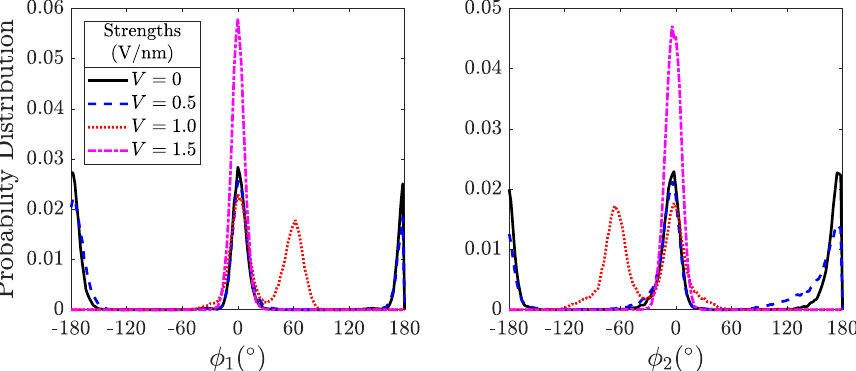
Figure 5. Relative orientation vectors of the molecules in the new crystals obtained upon application of e-field in y-direction on an initally α -glycine crystal with V = 0.5,1.0 and 1.5 V/nm. ( Left ) distribution of φ 1 angles, ( right ) distribution of φ 2